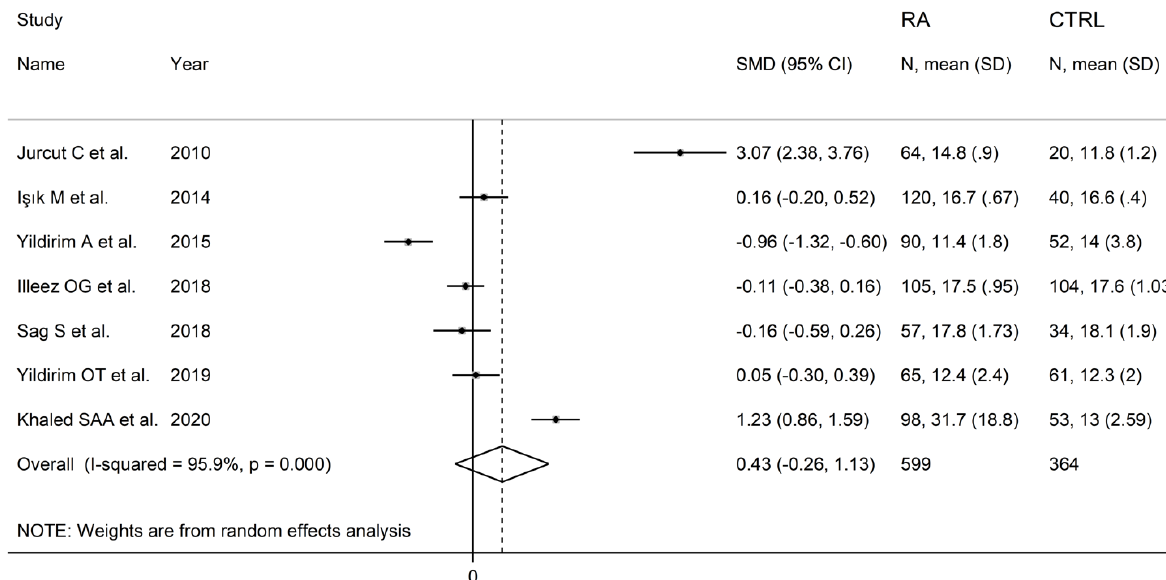
Figure 8. Forest plot of studies examining the platelet distribution width in patients with rheumatoid arthritis and healthy controls.